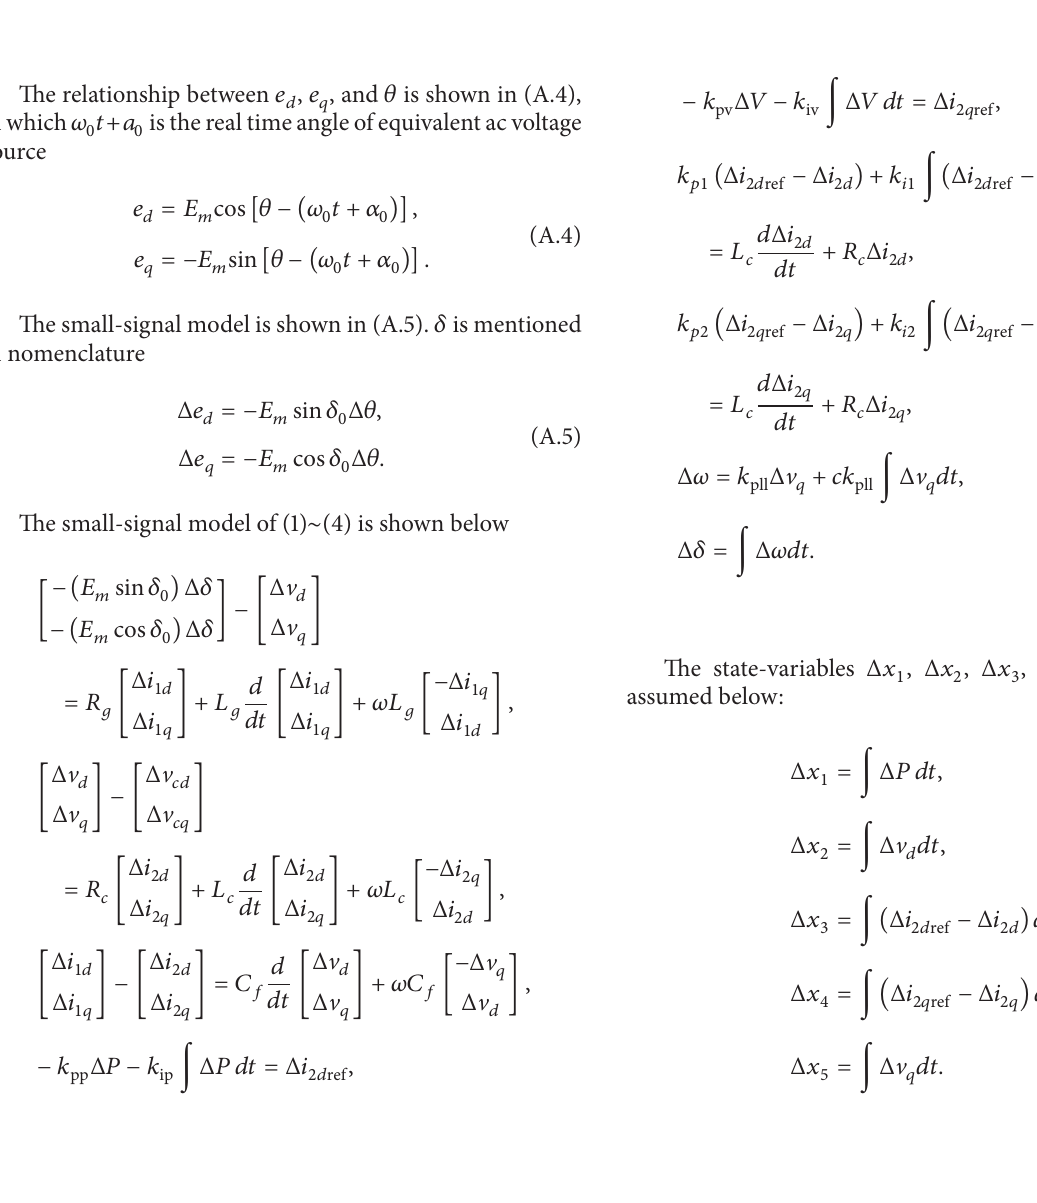
Figure 13: The power transfer limitations with the advanced PLL